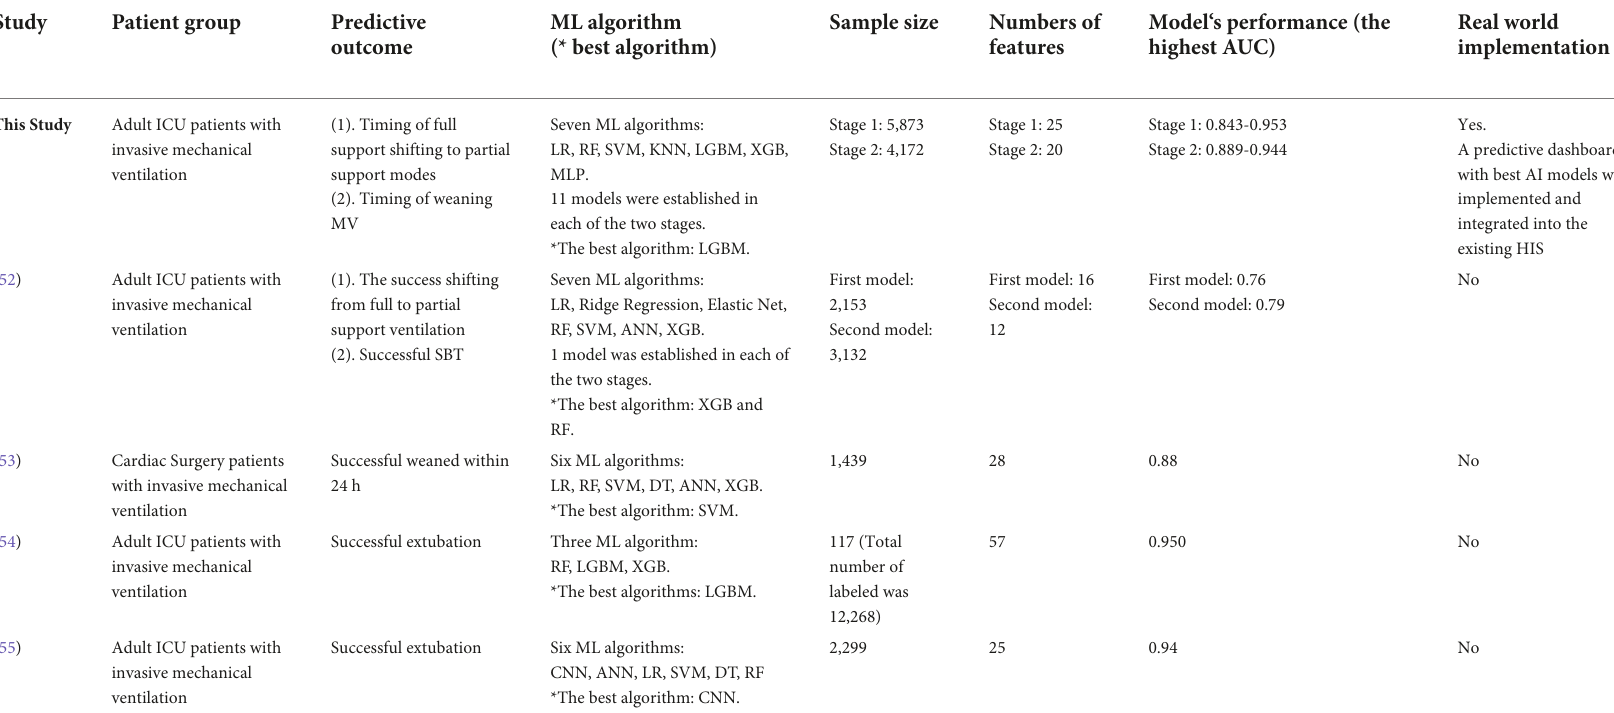
TABLE 6 A comparison with related